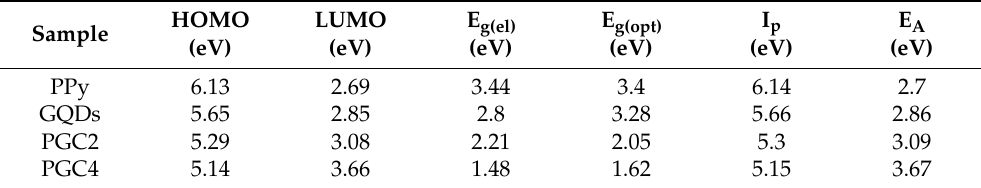
Table 2. Electrochemical study of the PPy, GQDs, and PGC